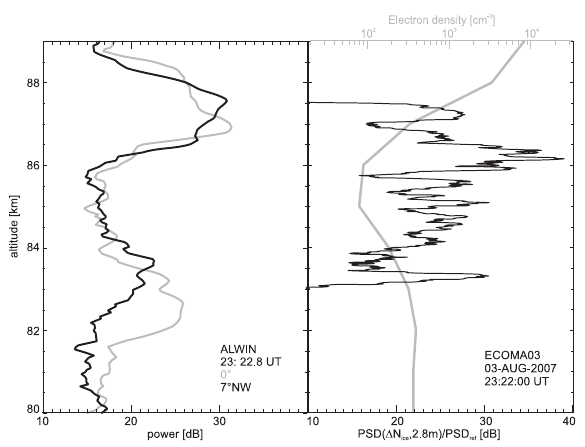
Fig. 5. Comparison of radar power and charged aerosol density fluctuations. Left panel: ALWIN radar power from vertical (0 ◦ , grey) and 7 ◦ NW-tilted beam (black) observed near ECOMA launch time. Right panel: charged aerosol density fluctuations at ALWIN’s Bragg scale (2.8m) in dB (black) and absolute electron density pro- file (grey) measured by the radio wave propagation technique from Friedrich et al.